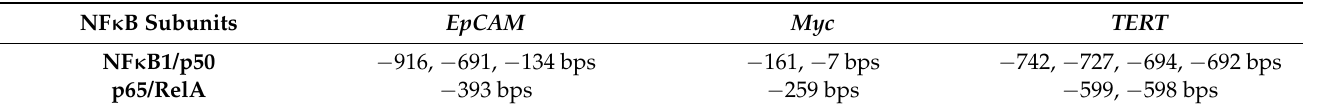
Table 2. Binding sites of NF κ B1/p50 and p65 subunits within the promoter regions (1 kb from TSS) of EpCAM , Myc , and TERT genes.